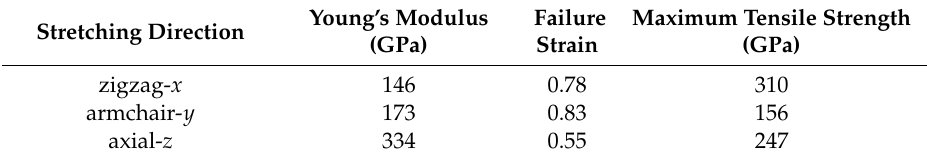
Table 1. Mechanical proprieties of BNHCs under the tensile loading along di ff erent directions. Young’s Modulus Stretching Direction